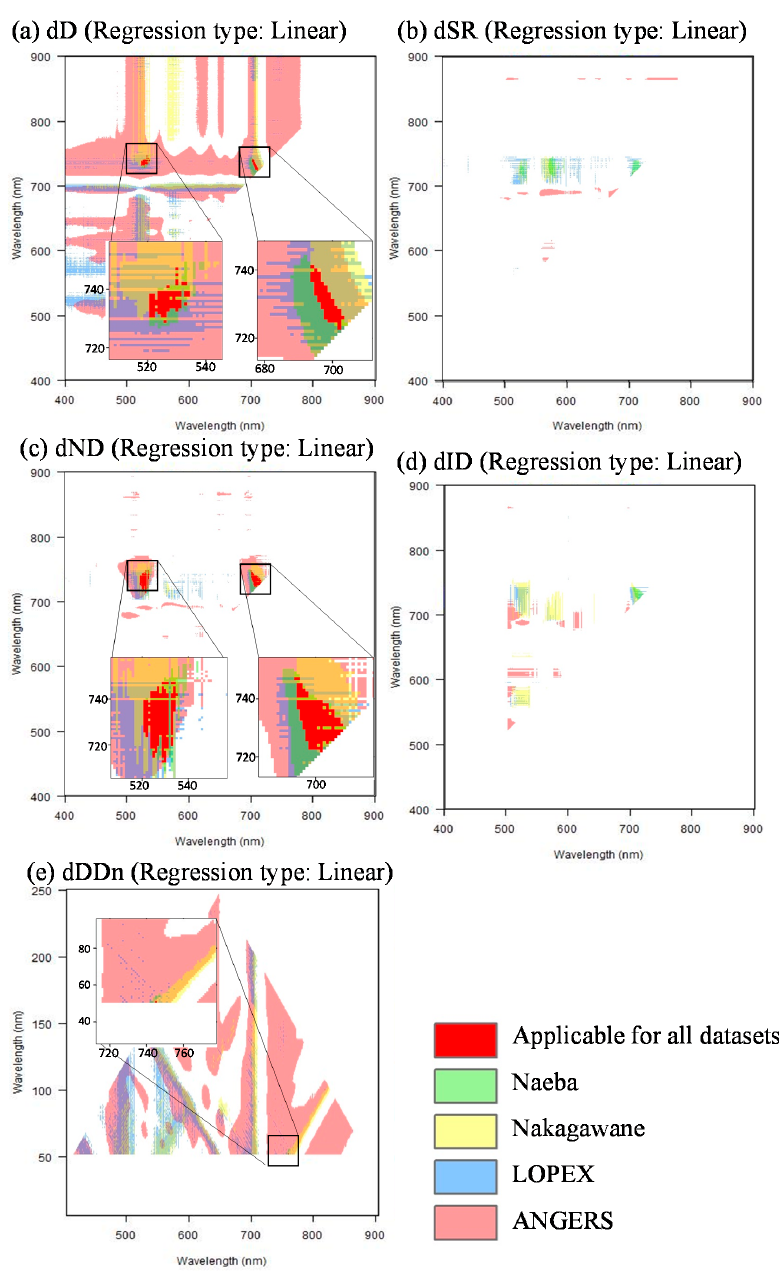
Figure 6. Categories based on RPD with different type indices using first-order derivative spectra (linear regression).